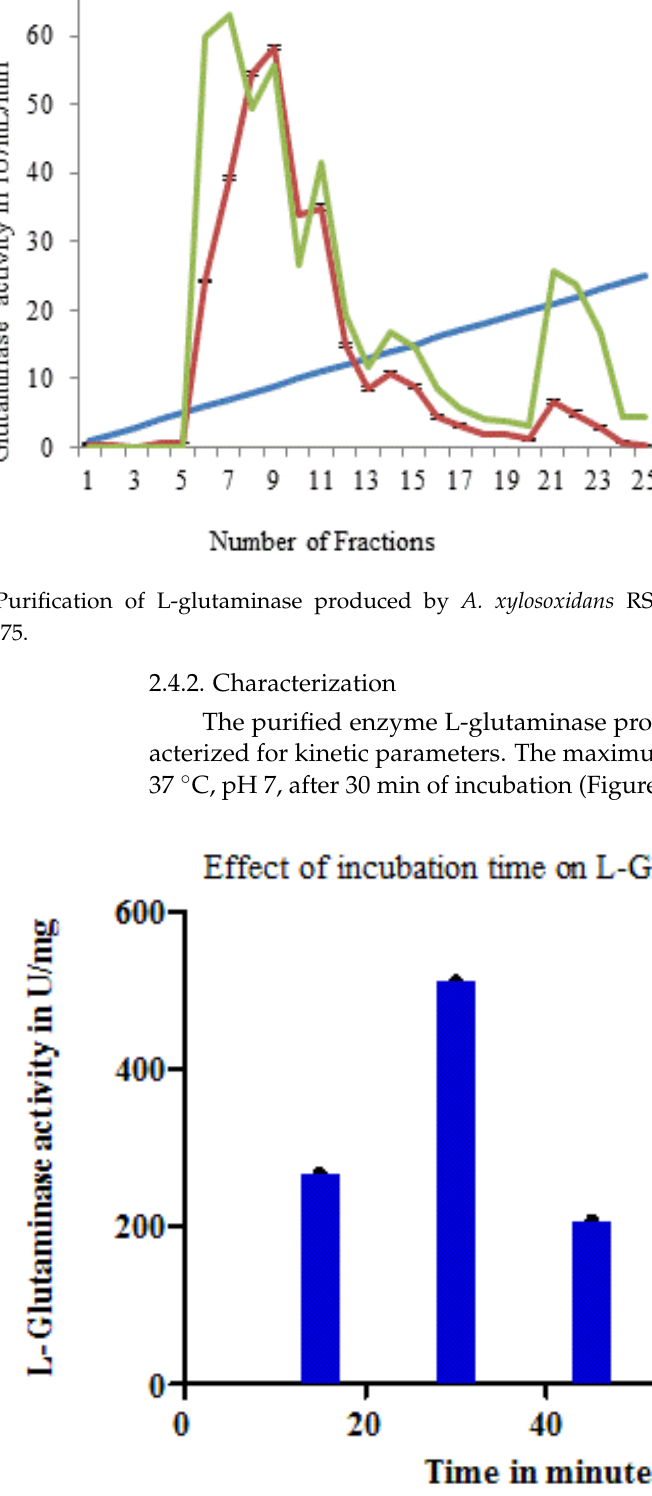
Figure 10. Effect of incubation time on L-glutaminase activity produced by A. xylosoxidans RSHG1 at 37 ◦ C, pH 7. The maximum velocity (Vmax) and Michaelis–Menten constant (Km) of the purified enzyme were 443.8 U/mg and 0.236 mM, respectively, calculated with the Michaelis and Menten plot (Figure 11). The enzyme gained the highest activity of 505 U/mg at a pH of 7 (Figure 12) and was stable at a pH of 6.5 – 8.0. L-Glutaminase from A. xylosoxidans RSHG1 showed thermal stability between 40 and 50 °C, while maximum activity (520 U/mg) was observed at 40 °C (Figure 13). The effect of metal ions and inhibitors on L-glutaminase produced by A. xylosoxidans RSHG1 was checked (Figure 14). Enzyme activity was in- creased with the addition of CaCl 2 , BaCl, KCl and NaCl and inhibited by EDTA, CoCl 2 , HgCl, ZnSO 4 , MgSO 4 and FeSO 4 . The effect of different concentrations of NaCl on purified L-glutaminase produced by A. xylosoxidans RSHG1 resulted in the highest activity of 822 U/mg with 8 % NaCl; a further increase in the salt concentration decreased enzyme activ- ity (Figure 15). After immobilization on agar medium, the enzyme was stable for 3 weeks. Its activity was almost similar up to 21 days. The immobilized enzyme ’ retained good activity (23 U/mg.)